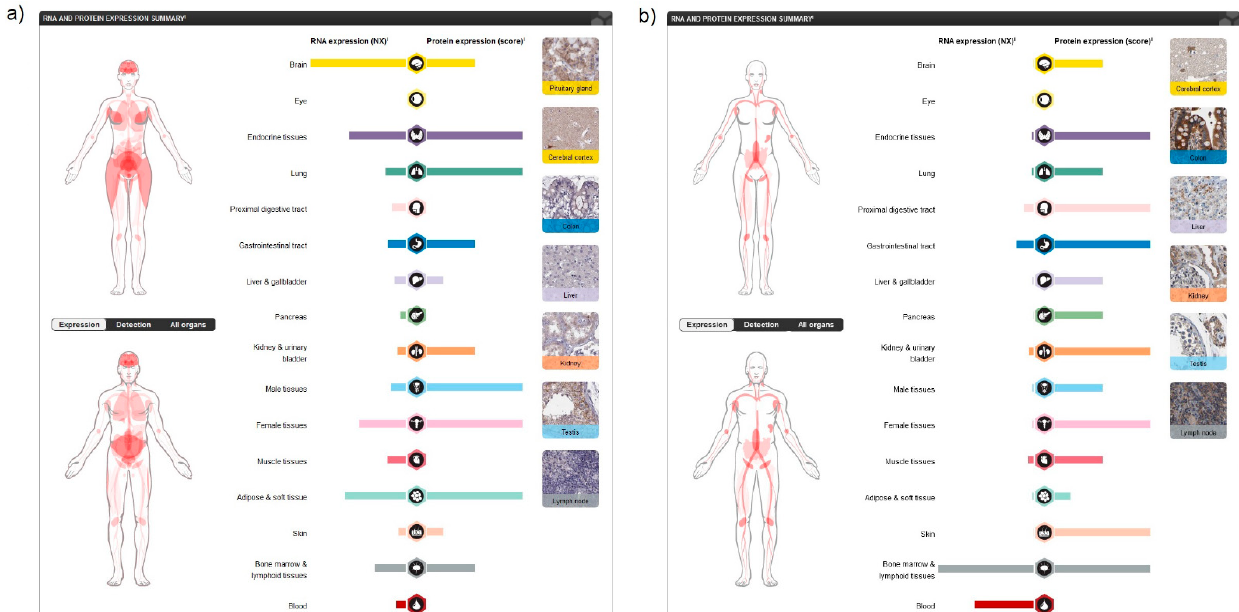
Figure 1. A schematic pictorial model of ( a ) CB1R and ( b ) CB2R expression in human organs and tissues according to the Tissue Atlas of the Human Protein Atlas database [10]. mRNA expression overview shows RNA as the consensus dataset based on a combination of three sources—RNA-sequencing data from internally generated Human Protein Atlas (HPA), RNA-sequencing data from the Genotype-Tissue Expression (GTEx) project and Cap Analysis of Gene Expression (CAGE) data from the Functional ANnoTation Of the Mammalian genome 5 (FANTOM5) project. When available protein data for which a knowledge-based annotation gave inconclusive results, no protein expression data were displayed. Nx—Normal- ized eXpression (resulting transcript expression values calculated for each gene in every sample).